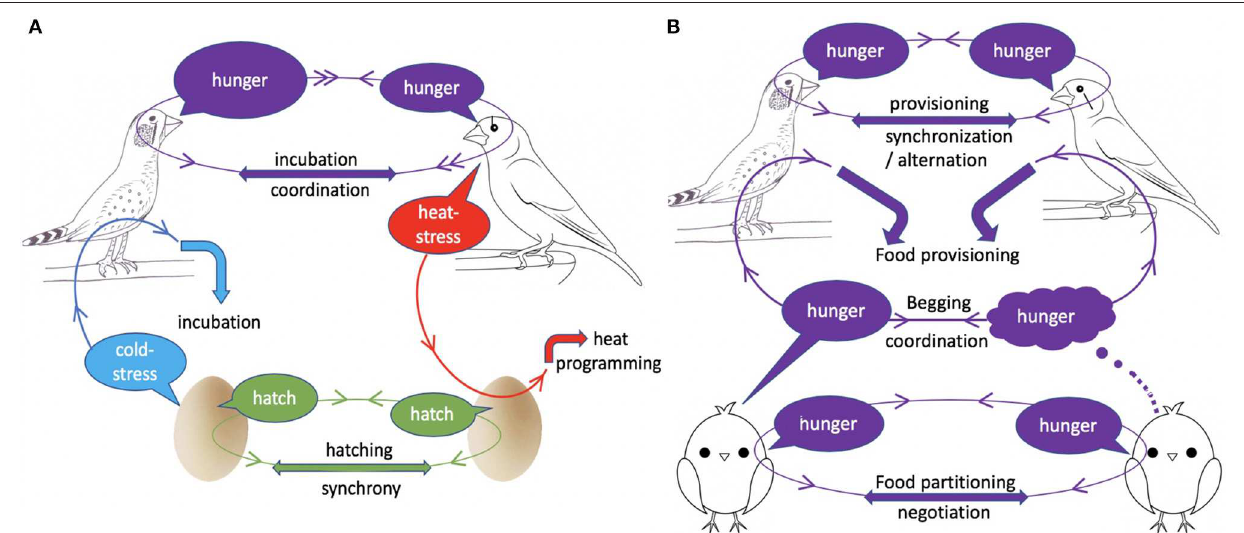
FIGURE 1 | The place of acoustic communication between family members during incubation (A) and nestling rearing (B) . During incubation (A) , parents coordinate incubation by signalling their hunger levels through calls; vocalisations may also signal (i) parental heat-stress to embryos, which alters offspring developmental response to heat, (ii) embryonic cold-stress to parents, which may optimise incubation temperature, and (iii) eminence of hatching, which allows hatching synchronisation. During nestling rearing (B) , offspring vocally negotiate food partitioning among themselves and coordinate begging to increase total provisioning from the parents, whilst parents coordinate and negotiate provisioning. “Information loops” (circles with arrows) show the receiver of each signal and the response it